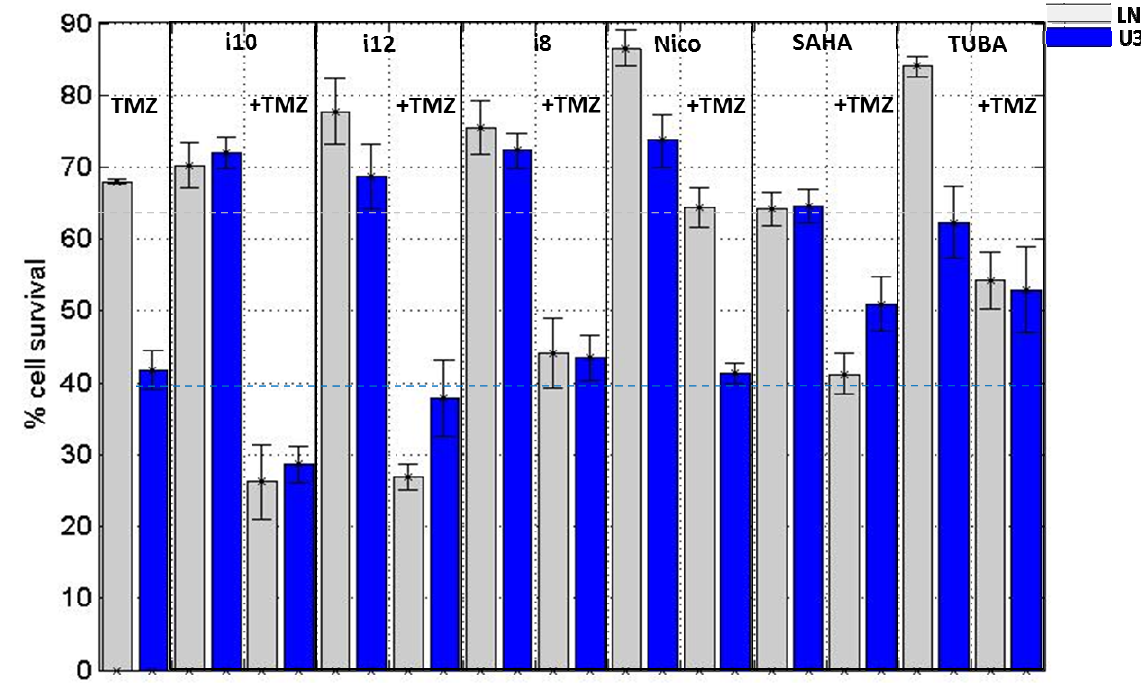
Figure 3. Cell survival measurements following exposure of cells to temozolomide (TMZ) or compounds i10, i12, i8, nicotinamide (Nico), SAHA and tubastatin A (TUBA). Shown are the cell survival measurements for individual treatment, as well as combined cell treatment with TMZ and studied compounds. Error bars show the standard error of the mean for three replicated measurements. The same amounts of compounds were used for treatment in two cell lines (amounts listed in Table 2). Cell survival measurements were performed following 72 h